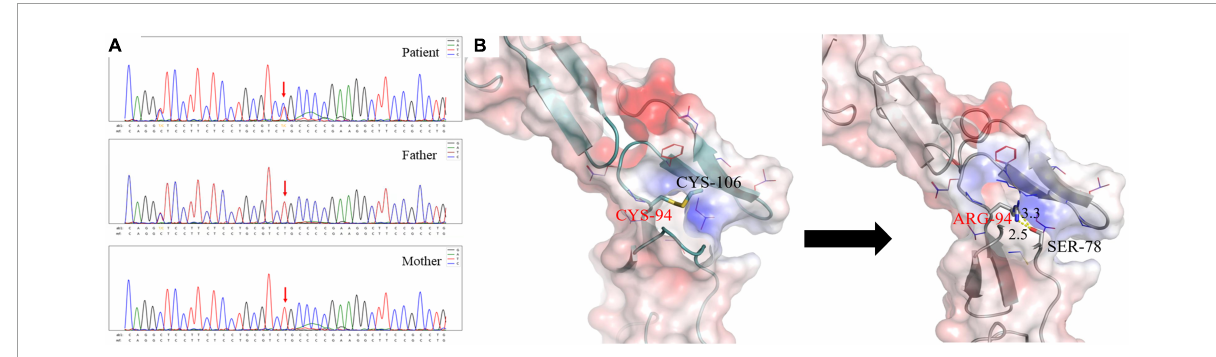
FIGURE2 (A) The patient carried a heterozygous mutation in the UMOD gene c.280T > C (p.C94R), and neither of her parents carried this mutation. (B) Different interaction patterns in wild type and p.C94R mutant. The left one is for the wild-type structure and the right one is for the p.C94R mutant. The electrostatic surface is colored according to a scale from red (negative, min = − 5.0 kT/e) to blue (positively, max = 5.0 kT/e). The backbone structure is shown in cartoon representation, Cys94, Cys106, and Ser78 as sticks with the rest of the side chains as lines. The distance between the hydrogen donor and the hydrogen acceptor is marked in the unit of Angstrom